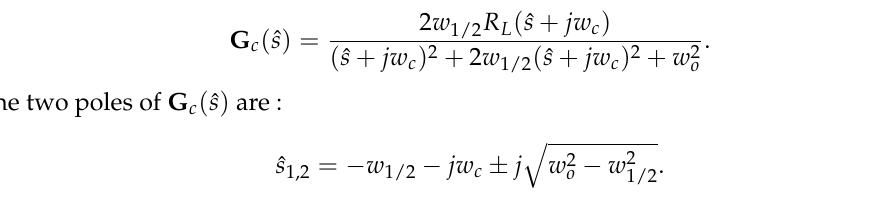
Table 2. s and ˆ s domain representation of impedance in cavity circuit model. Element